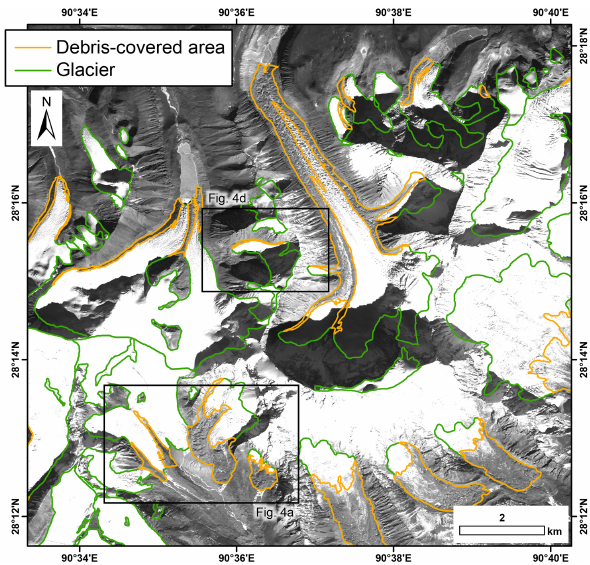
Figure 3. Examples of manually delineated outlines of glaciers and debris-covered